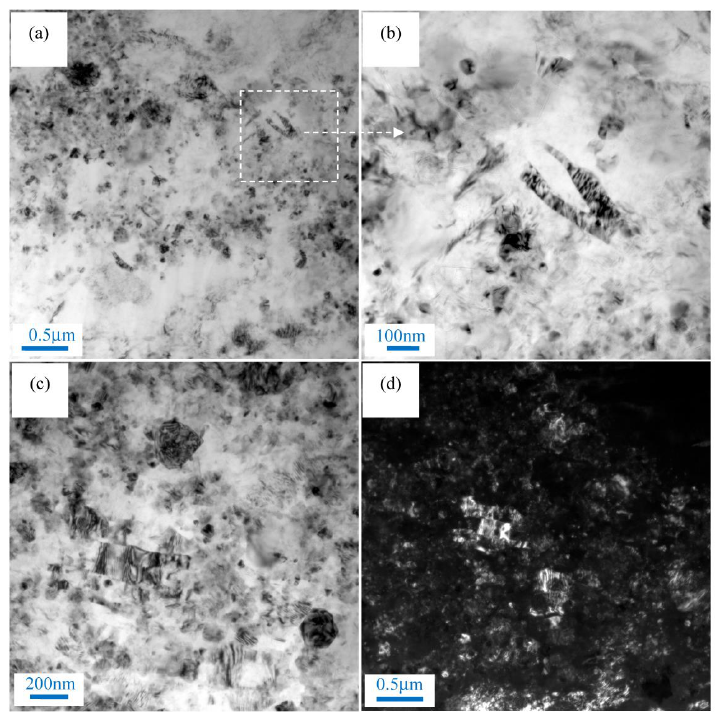
Figure 3. Nanoparticle distribution of nano-SiCp/AZ91 composite after single-pass forging at 350 °C: ( a ) SiC nanoparticles and twin; ( b ) SiC nanoparticles and twin at higher magnification; ( c ) bright field image and ( d ) dark field image of SiC nanoparticles and dynamic recrystallization (DRX) grains.